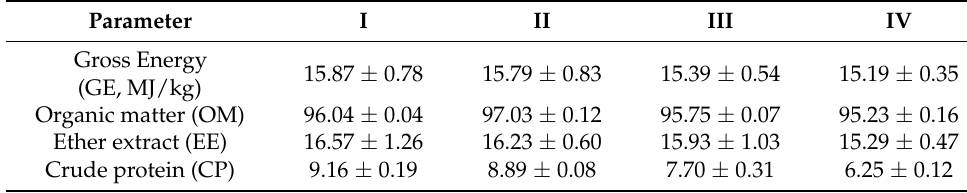
Table 2. Chemical composition of dried concentrate supplements (%, DM).